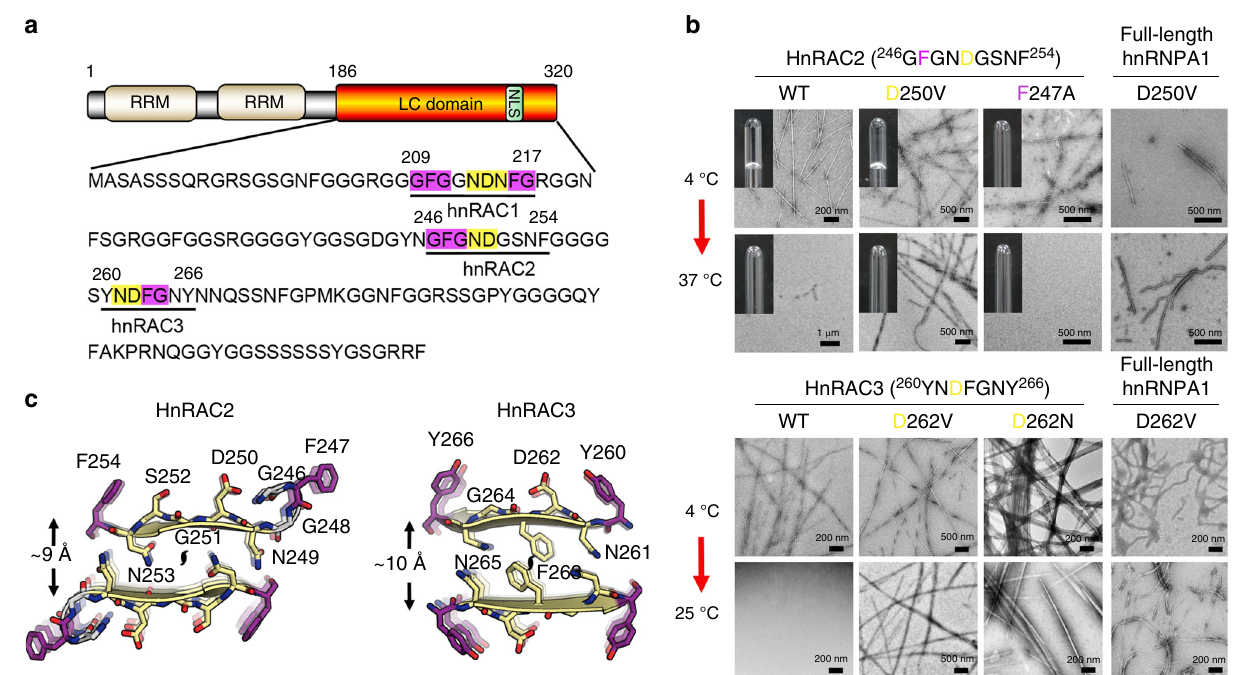
Fig. 4 Identi fi cation and characterization of hnRNPA1 RAC2 and RAC3. a HnRAC2 and hnRAC3 contain the characteristic (N)D(N) (highlighted in yellow) and (G)F/Y(G) (highlighted in magenta) motifs identi fi ed in hnRAC1. RRM: RNA-recognition motif. NLS nuclear localization sequence. b Amyloid fi bril and/or hydrogel formation of hnRAC2, hnRAC3 and full-length hnRNPA1 mutants. Amyloid fi brils were imaged by TEM. Reversibility of amyloid fi brils and hydrogels was monitored as temperature increased from 4 °C to 25 °C or 37 °C. c Structures of hnRAC2 and hnRAC3 fi bril spines modeled by Rosetta modeling. The fi bril core region of each model is highlighted in yellow. The fl anking aromatic residues are in purple. The distances between the sheet pairs are indicated. The twofold screw axis is indicated. The fi bril axis is perpendicular to the